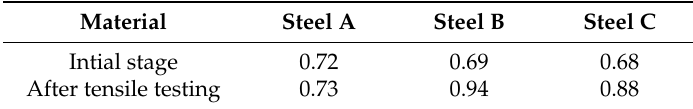
Figure 3. Deep-drawn cups at DR 2.0: ( a ) steel A; ( b ) steel B; and ( c ) steel C.